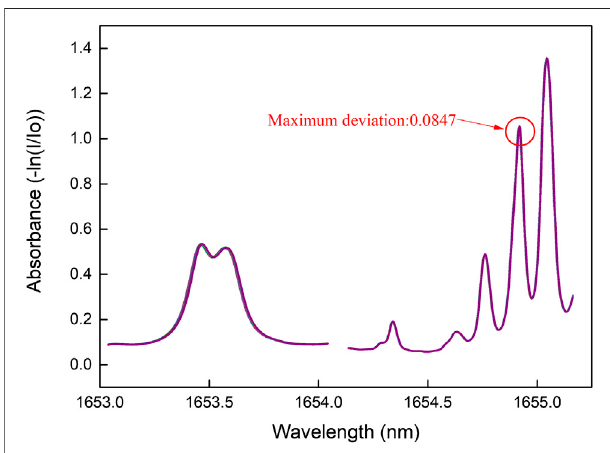
FIGURE 3 | TDLAS platform and test